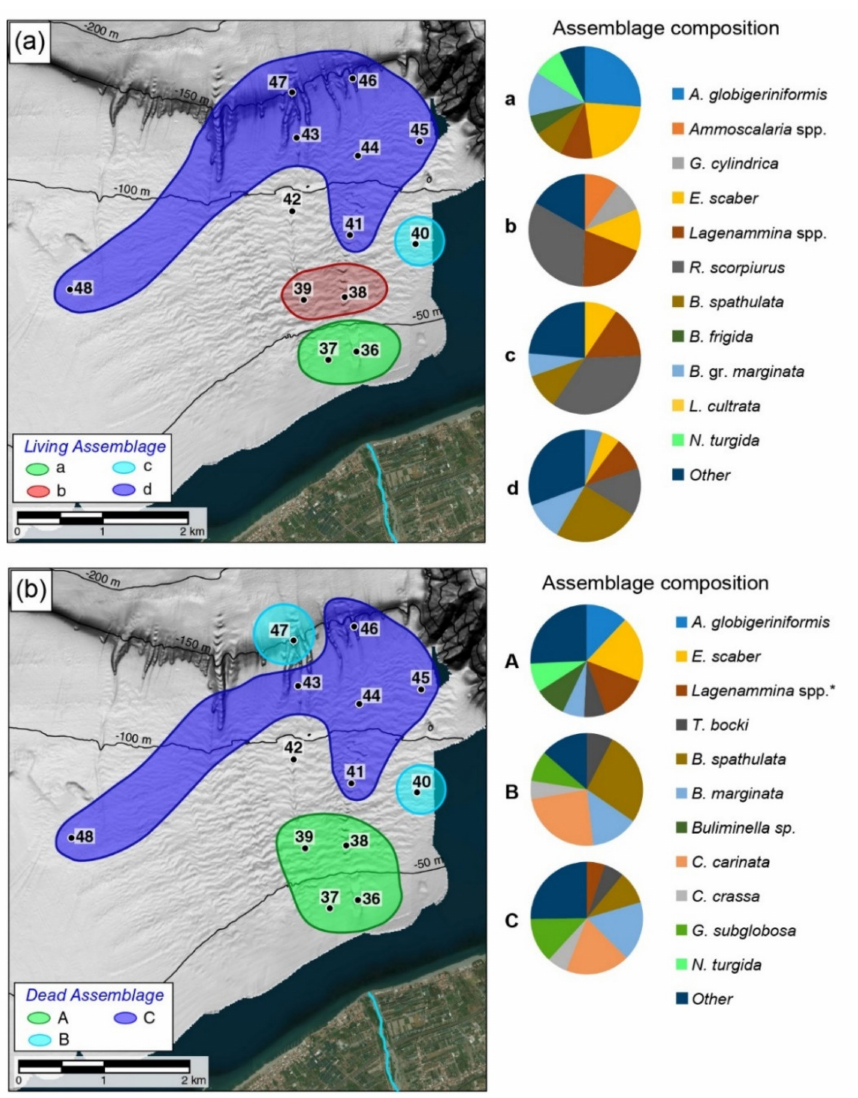
Figure 5. Spatial distribution of the foraminiferal assemblages identified from the cluster analysis and related pie charts representing the composition (>5%) of each assemblage: ( a ) living assemblages; ( b ) dead